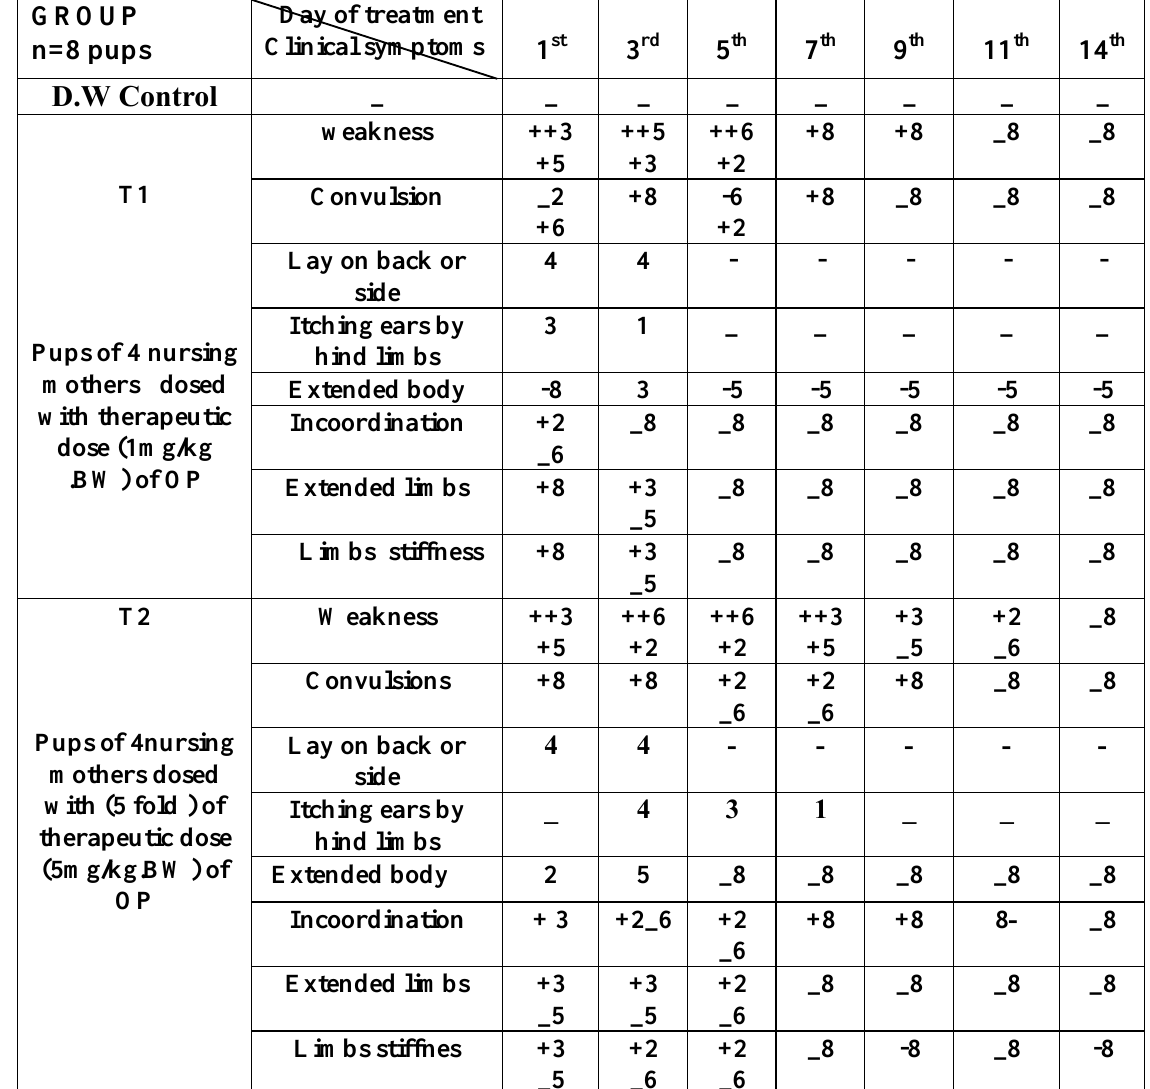
Table (2): clinical symptoms of mice pups dosed with two different doses by nursing mother of oseltamivir phosphate during lactation period